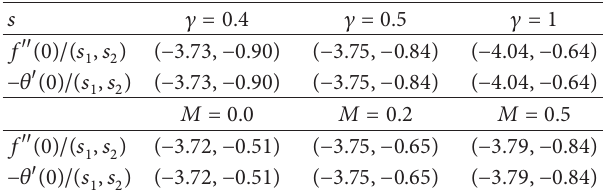
Figure3:Variationofskinfrictionwith 𝑠 forvariousvaluesof 𝛾 with 𝑀 = 0.5 , 𝜆 = 0.5 , and Pr = 1 . Table 2: Range of dual solutions for skin friction and rate of heat transfer with 𝜆 = 0.5 and Pr = 1